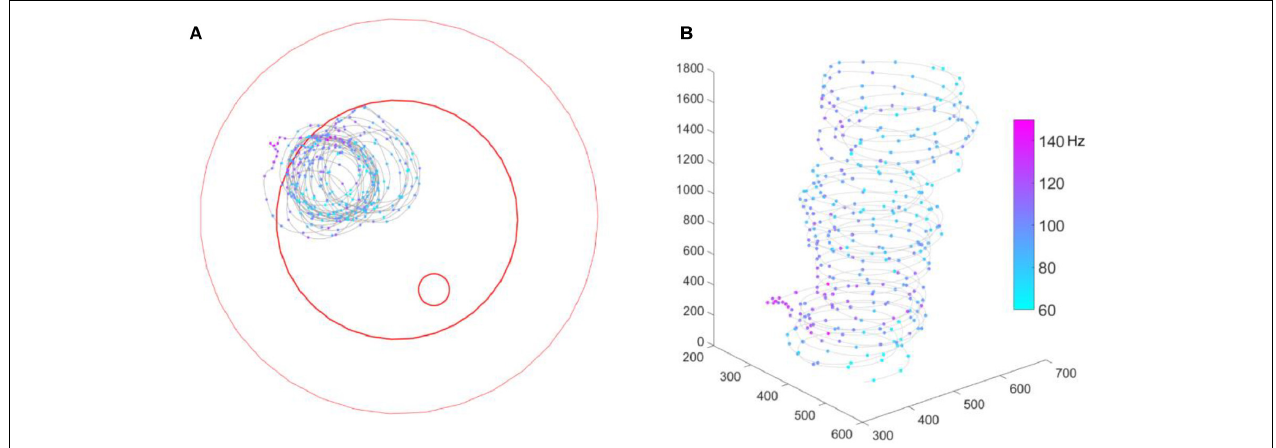
FIGURE 3 | Bee # 140508 running in a circle. (A) 2D bee trajectory from bird’s eye view; (B) same trajectory in 3D, time goes from down to up. In both sub-figures, the gray line shows the trajectory, each colorful dot on the trajectory shows a down-sampled bee location (per 0.5 s) and spike activity of that moment. The three red open circles from big to small mark the borders of the plate rim, ground paper and feeding disk, respectively.